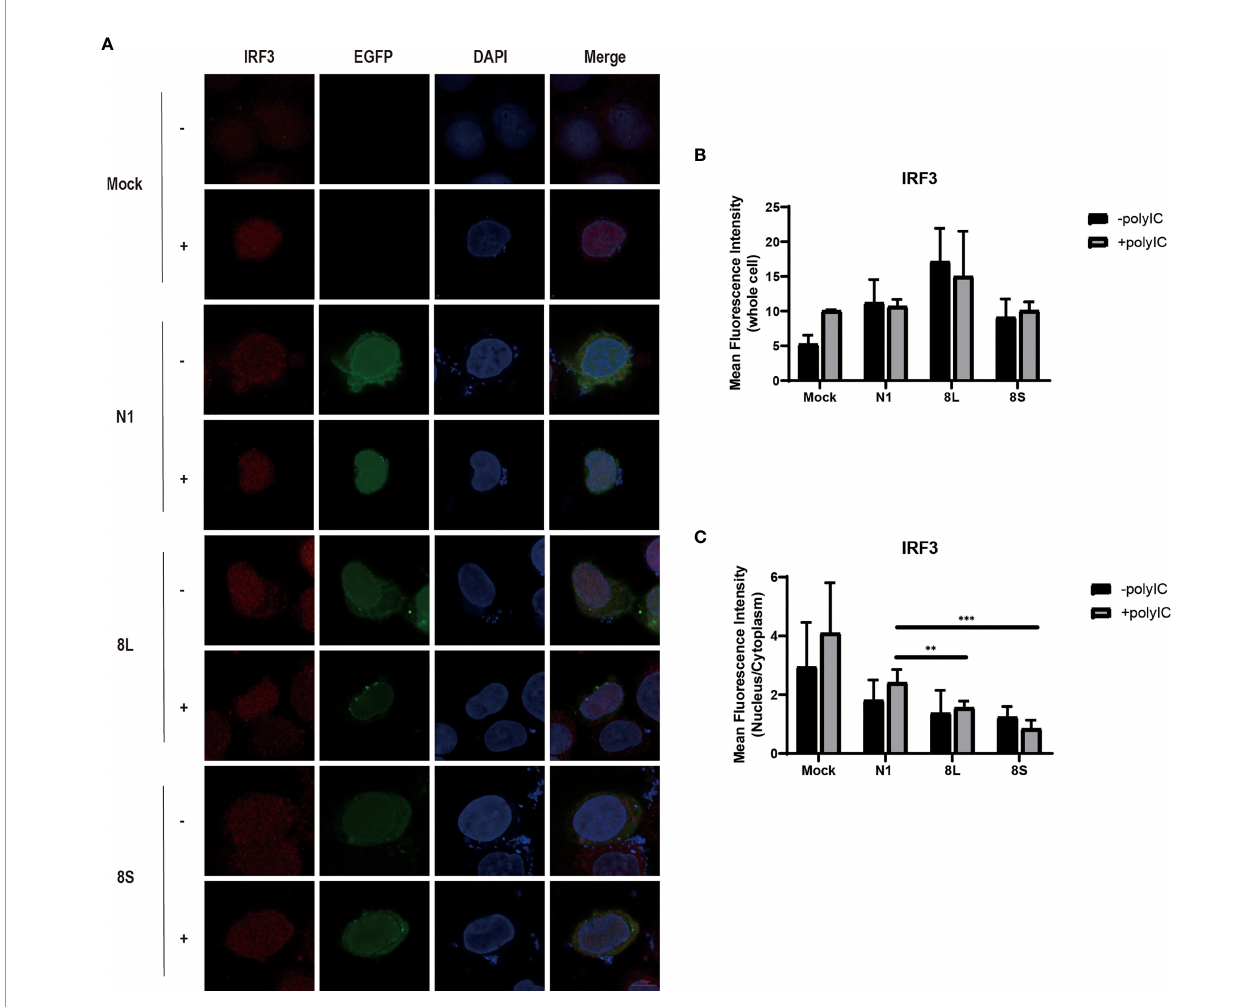
FIGURE 3 | The SARS-CoV-2 ORF8L and ORF8S proteins inhibit nucleus translocation of IRF3. (A) HeLa cells were co-transfected with indicated plasmids and poly(I:C) [-, no poly(I:C); +, poly(I:C)]. At 48 h after transfection, the cells were fi xed, blocked, and then incubated with a rabbit anti-IRF3 antibody overnight and with the corresponding coraLite594 antibody for 1 h and a confocal microscope was used to identify ORF8L, ORF8S proteins (green), and IRF3 (red) signals. The mean fl uorescence intensity of IRF3 of whole cells (B) or nucleus to cytoplasm (C) in positive-transfected cells was measured from over three cells in three fi elds of views. Scale bar, 10 m m. **P < 0.01; ***P < 0.001 versus empty vector (One-way ANOVA). ORF8L protein, 8L; ORF8S protein,